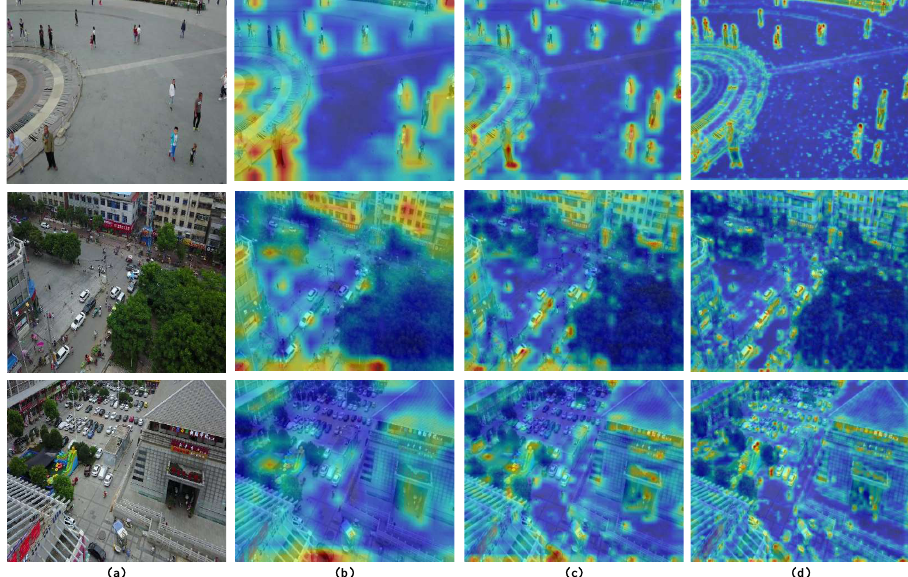
Figure 9. Original Image and feature visualization for images of different sizes. ( a ) Original Image. ( b ) Feature map of original size image. ( c ) Feature map of 2 × size image. ( d ) Feature map of 4 × size image. Warmer color indicates higher activation value in feature map, where would more likely to achieve better results in the subsequent identification and positioning